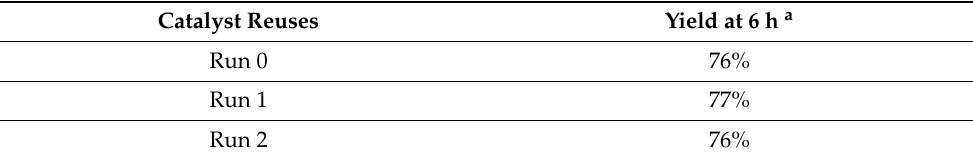
Table 4. Screening at 4:1 molar ratio of ethyl levulinate:glycerol. Catalyst Reuses